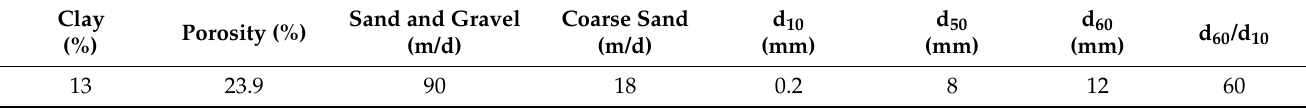
Table 1. Parameters of sand tank